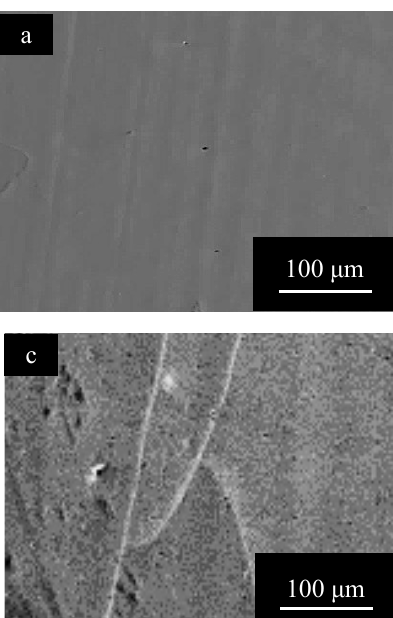
Figure 9. SEM images of the surface of specimens with t a = 1800 s and t s = 1200 s, obtained for ( a ) pure Al, ( b ) 1050-Al alloy, ( c ) 3003-Al alloy, and ( d ) 5052-Al alloy. Anodizing conditions are described in Figure 3. Pore sealing was carried out by immersion in boiling water for t p = 1200 s. Figure 10 shows SEM images of the surface of specimens with t a = 3600 s and t s = 1200 s, obtained for (a) pure Al, (b) 1050-Al alloy, (c) 3003-Al alloy, and (d) 5052-Al alloy. The